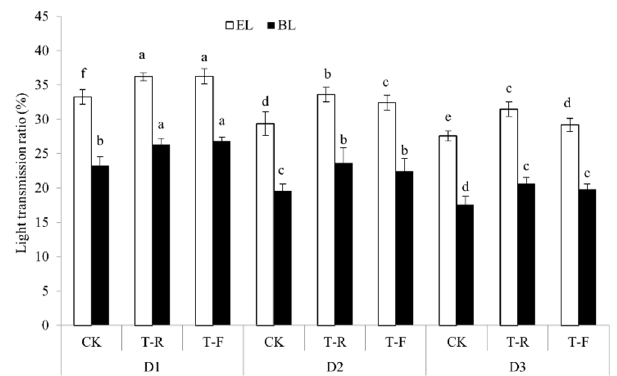
Figure 6. Light transmission ratio (LT) at different leaf layer under different planting patterns (2018). Different letters above the bars indicate in the same leaf layer that there is a significant difference between treatments at p < 0.05. D1, D2 and D3 represent maize were planted at 60,000, 75,000 and 90,000 plants ha − 1 , respectively. CK and T represent maize were planted in the conventional flat planting pattern and in the stereo-planting pattern, respectively. T-R and T-F represent maize were planted on the ridge and in the furrow, respectively. EL and BL indicate light transmission ratio at ear leaf layer and bottom leaf layer, respectively. The vertical bar indicates the standard errors ( n = 3).